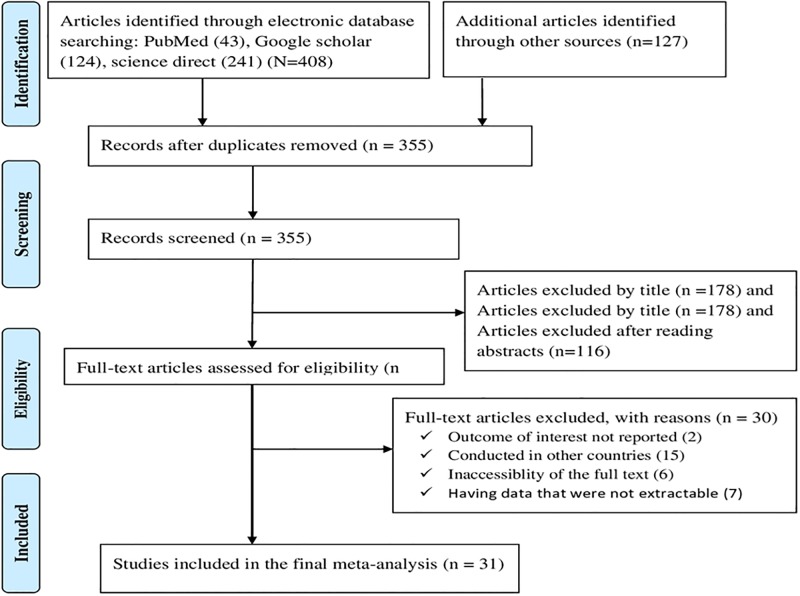
Flow chart of study selection for systematic review and meta-analysis of the prevalence and determinants of diarrhea among under-five children in Ethiopia.